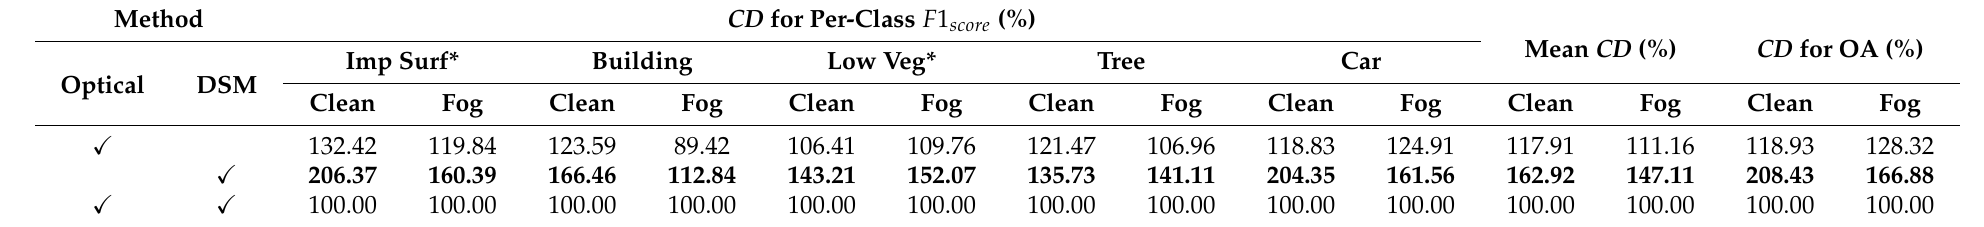
Table 6. Quantitative evaluation of CD on clean and fog corrupted variants of the Vaihingen test set about using different input data. Our framework is regarded as the reference and values above 100% denote a decrease in robustness compared with the reference. The highest CD is